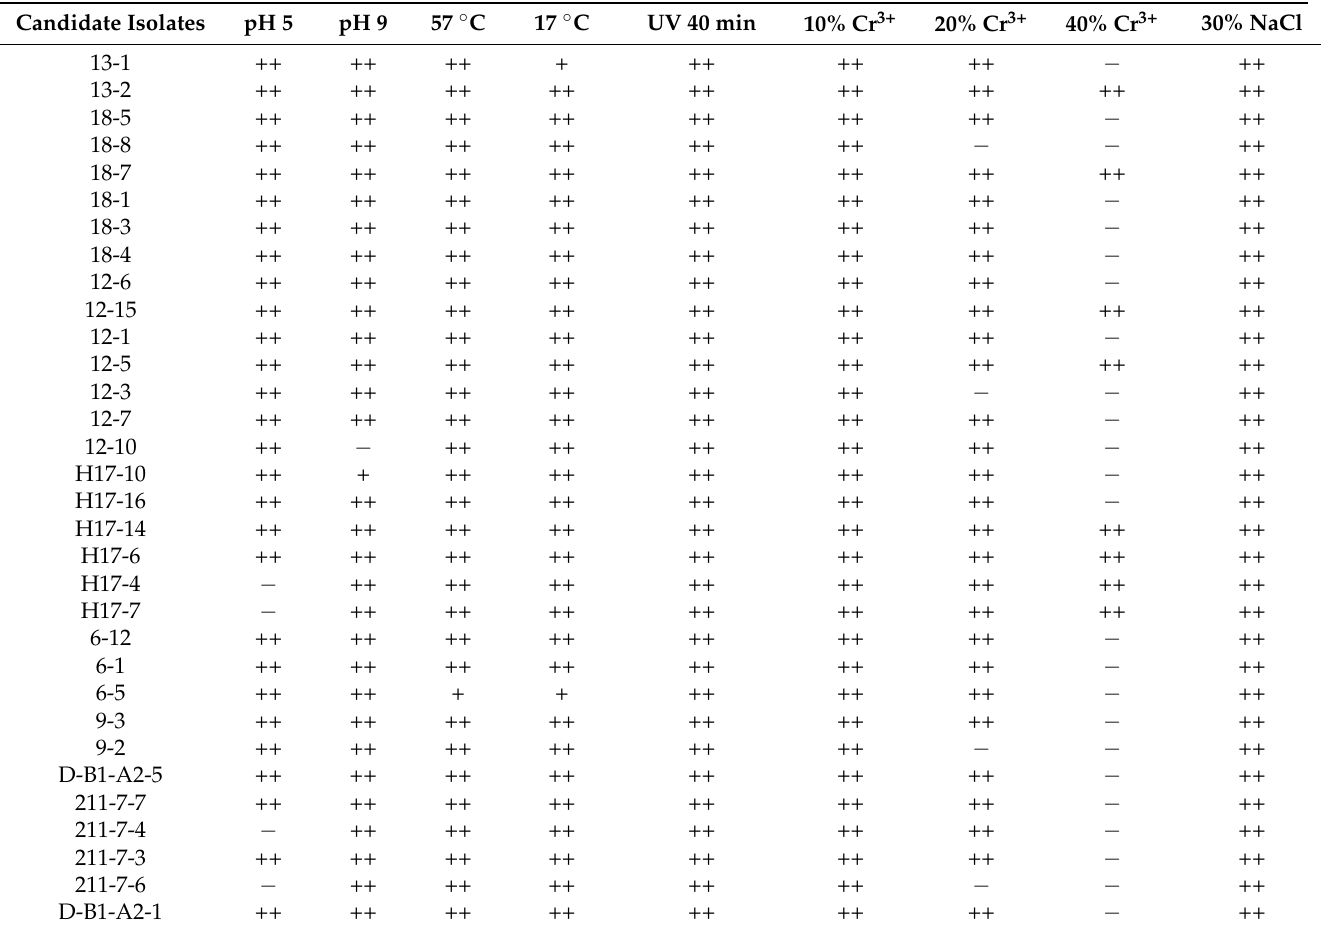
Table 1. Candidate isolates with good stress